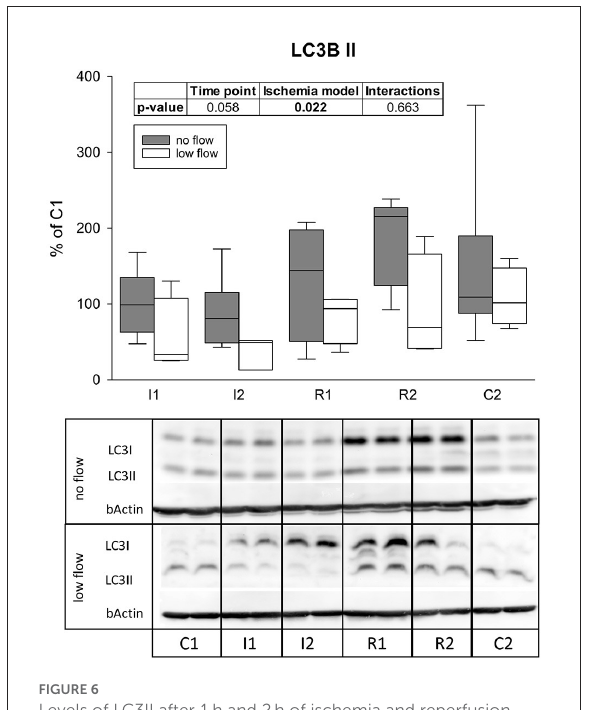
FIGURE6 Levels of LC3II after 1h and 2h of ischemia and reperfusion each indicate a differing regulation of autophagy in no and low flow ischemia. Boxes and error bars show the median, 10th, 25th, 75th, and 90th percentiles (no flow: gray; low flow: white); N = 6 (no flow) or 4 (low flow). The insert shows the result ( p -values) of the statistical analysis using a two-way RM ANOVA. Representative blots are shown below.